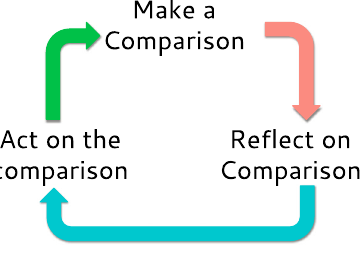
FIG. 1. Cycles of comparisons, reflection, and iteration in the SQILabs pedagogy from Ref.